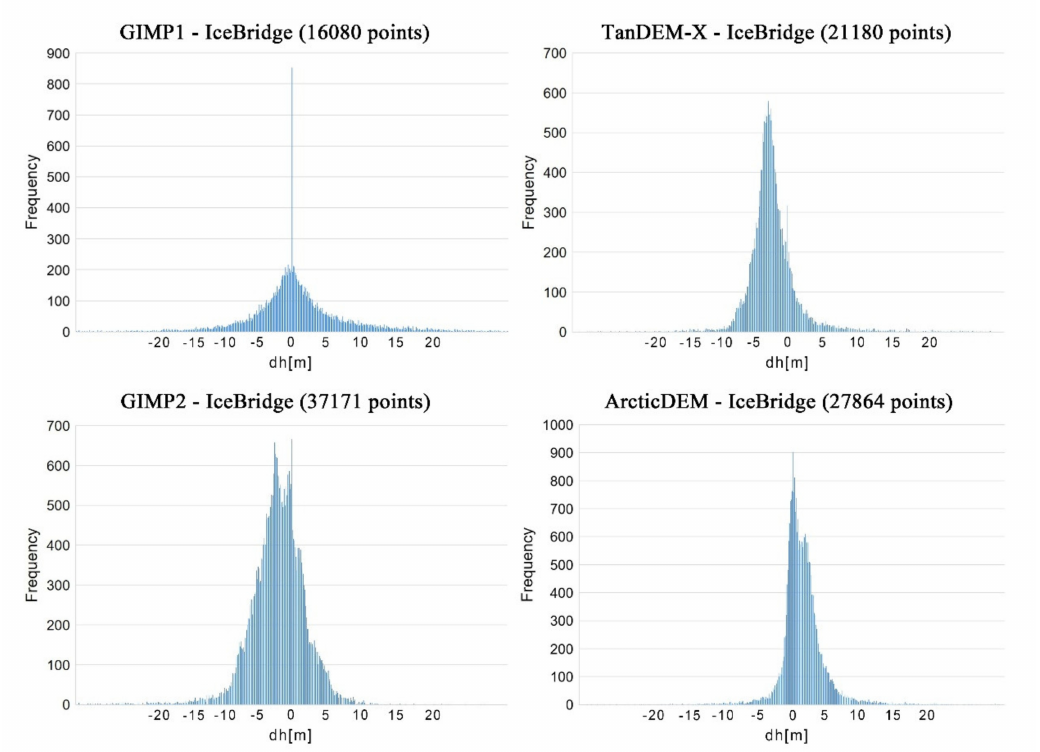
Figure 5. Histogram plots of height di ff erences for DEM minus